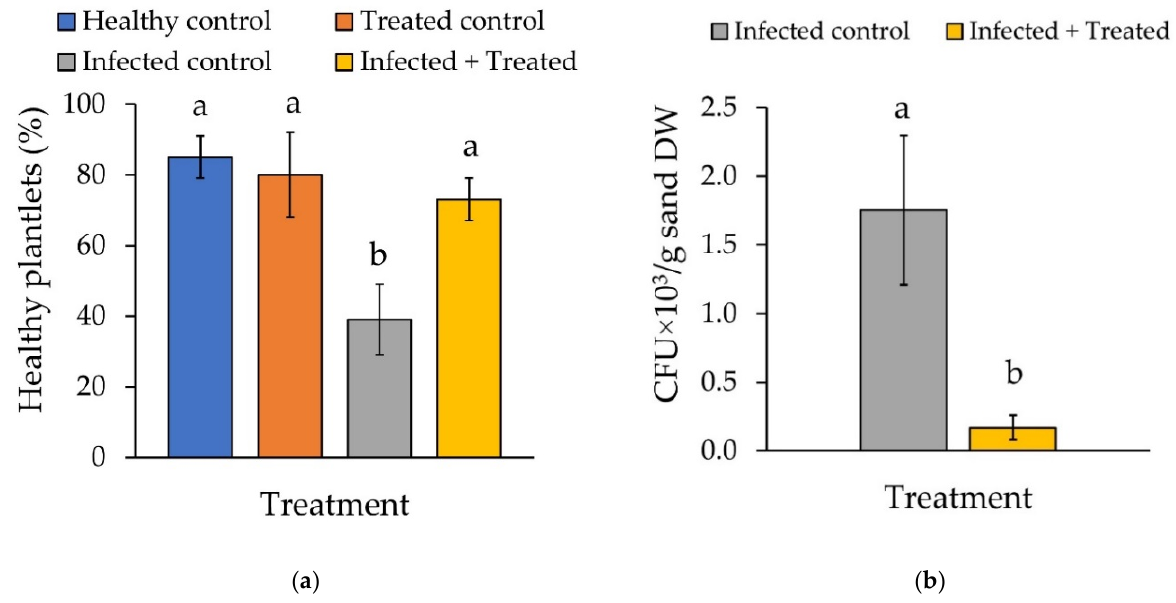
Figure 7. Effects of the treatment with the undiluted giant reed extract on the Pythium ultimum 22–zucchini pathosystem in sand: ( a ) percentage of healthy plantlets of zucchini in the infected and treated trays (yellow column) compared to the different controls (i.e., healthy, infected, or treated) 16 days after the treatment; ( b ) number of colony-forming units (CFUs) of P. ultimum 22 per g of sand dry weight (DW) in the infected and treated trays (yellow column) in comparison with the infected control, 14 days after the treatment. Bars represent the standard error of the mean. Columns labelled with the same letter did not differ for p ≤ 0.05 (Tukey’s test after one-way ANOVA).